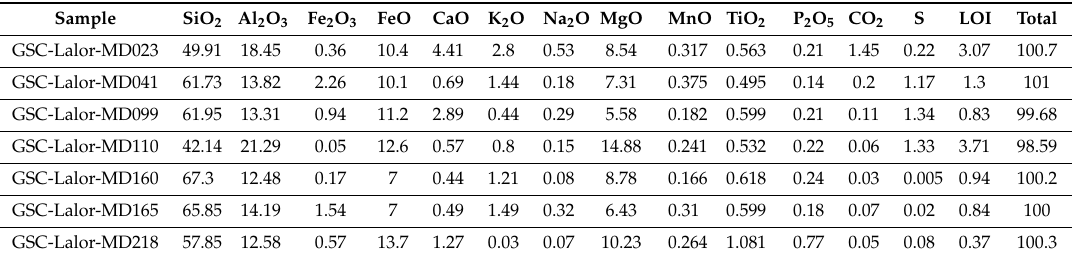
Table 7. Greenschist facies normative minerals for modeling the hydrothermal conduit .